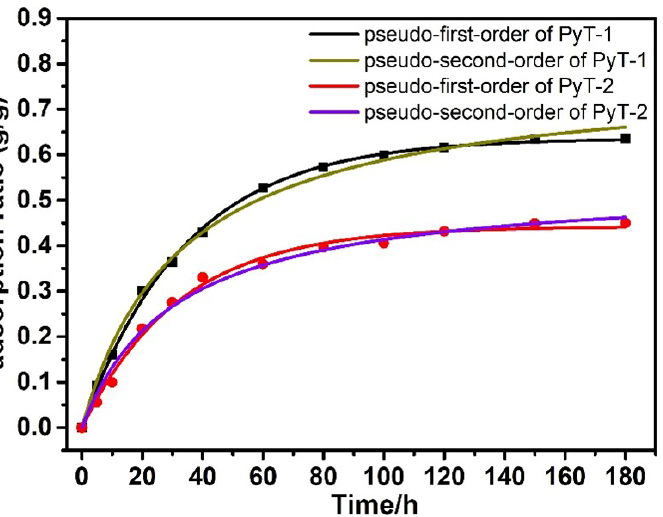
Figure 6. Iodine adsorption capacities of PyT-1 and PyT-2 in n -hexane with an iodine concentration of 400 mg L − 1 .